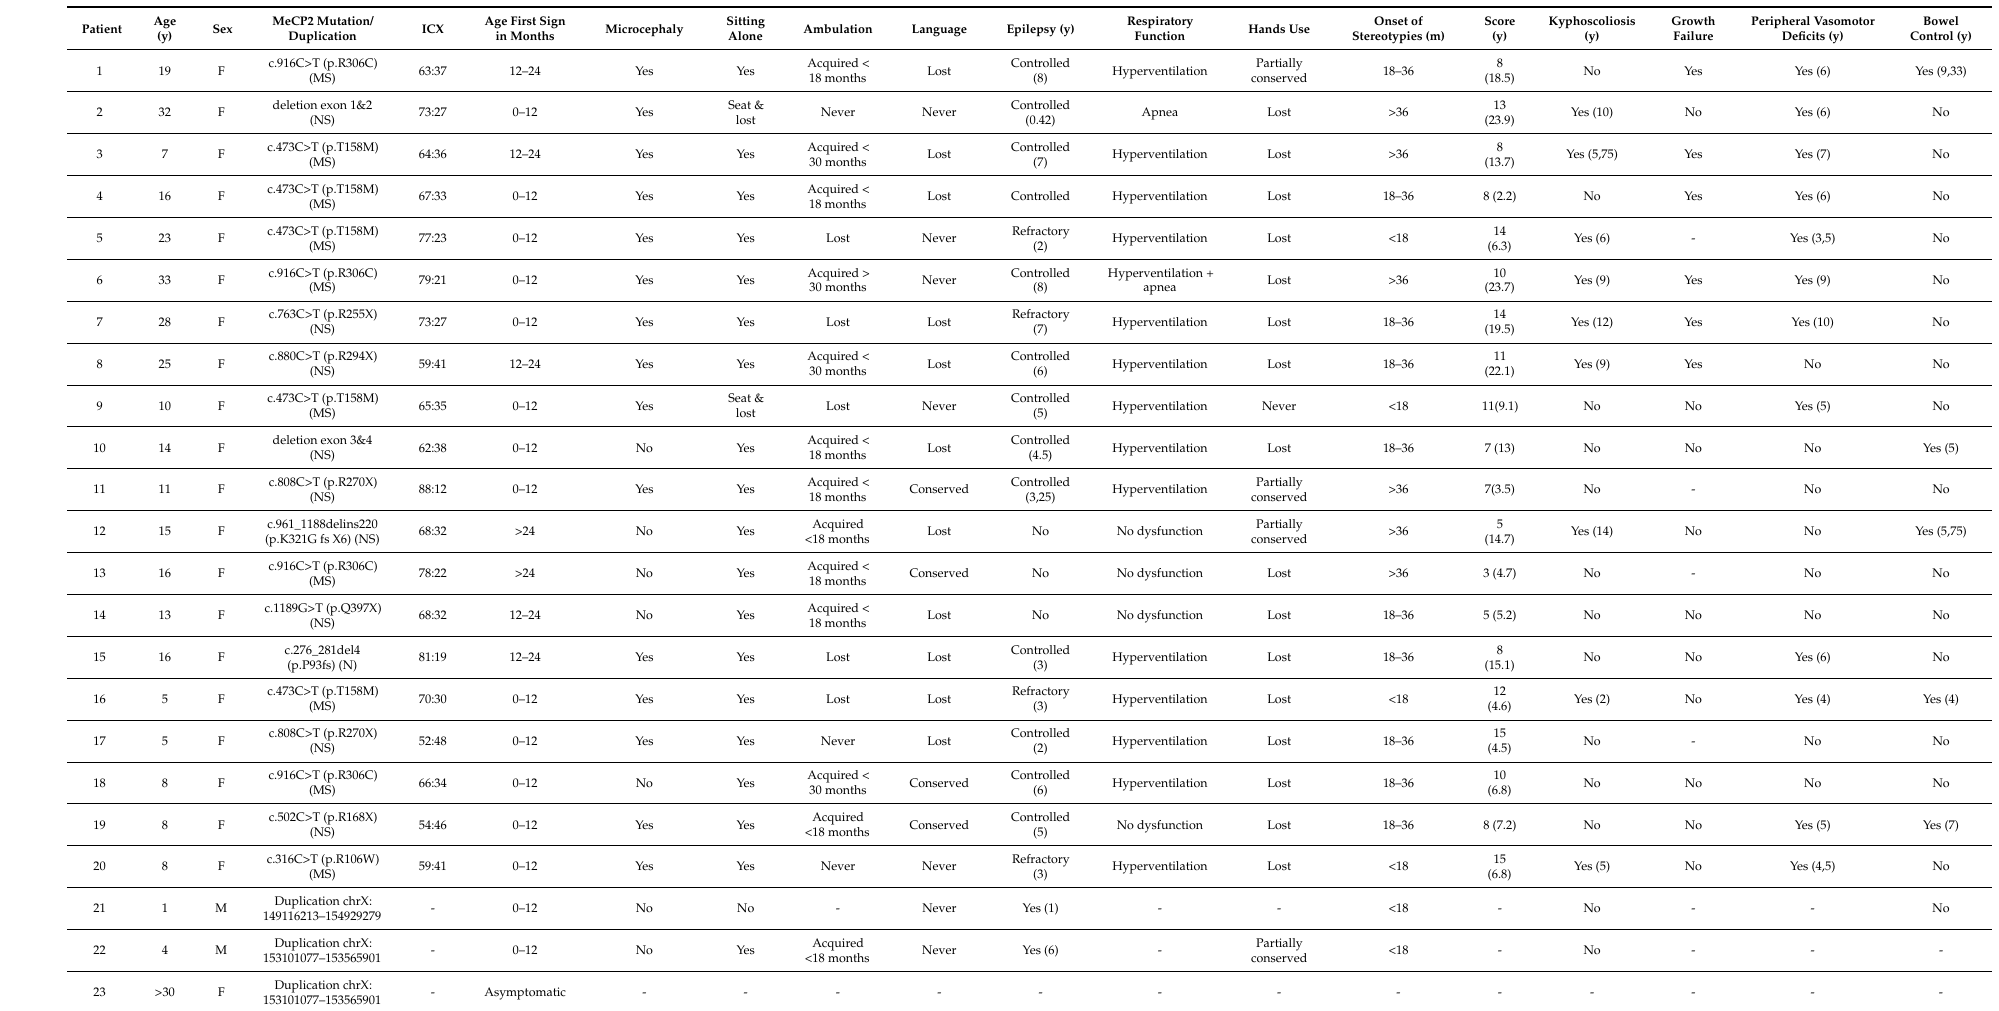
Table 1. Clinical and genetic characteristics of the